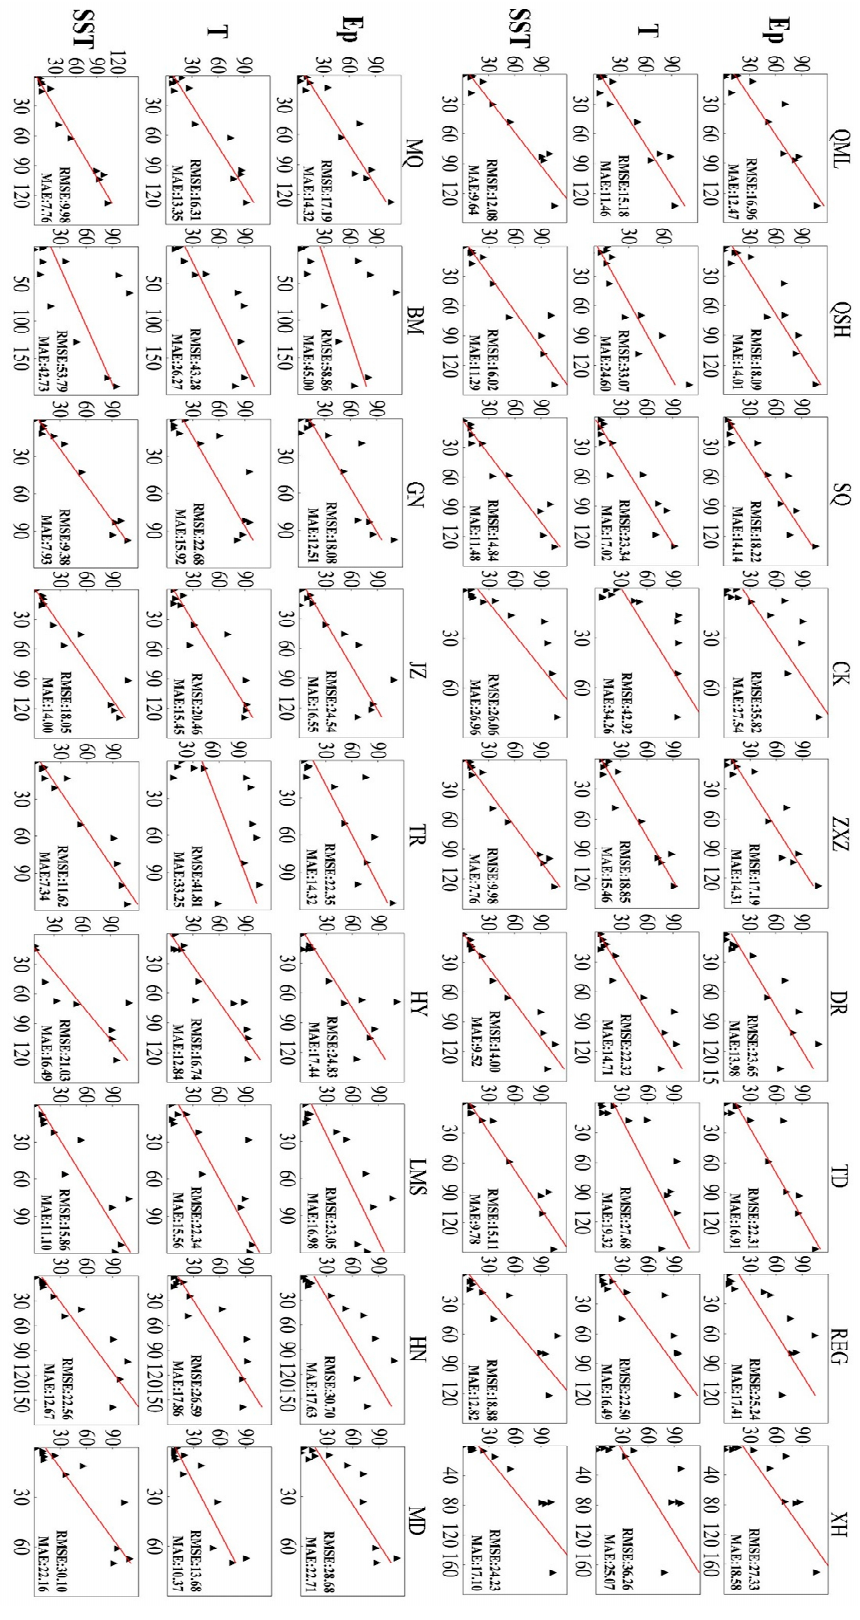
Figure 4. Prediction results of precipitation integrating SST, T, and Ep.